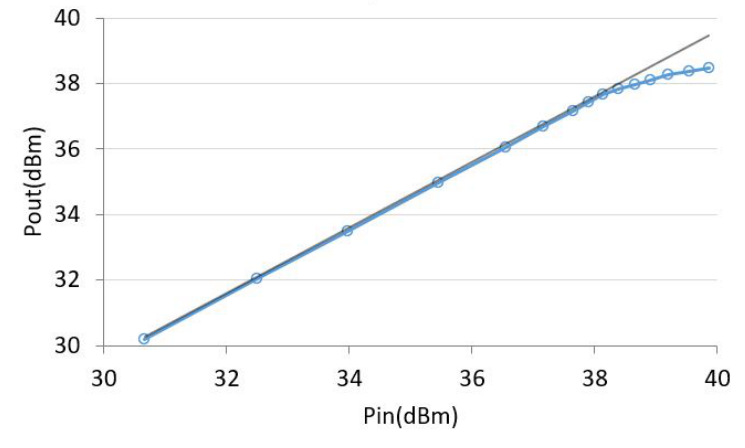
Figure 18. Measured input power compression point of the SPDT